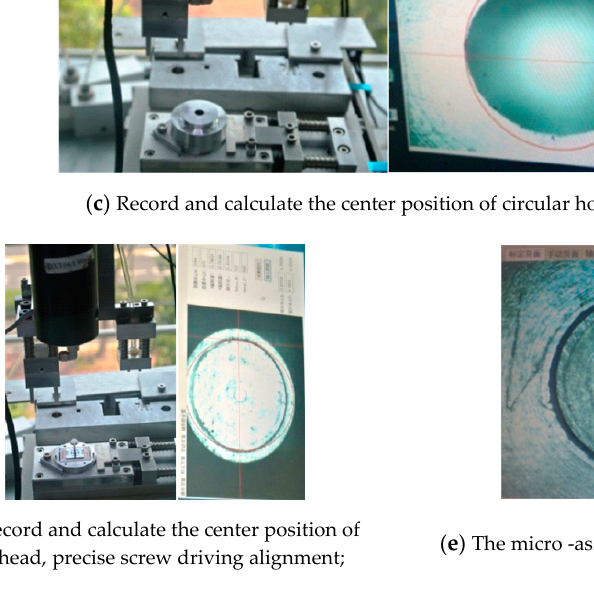
Figure 7. The micro-assembly processes based on visual aligning for MEMS skin friction sensor.